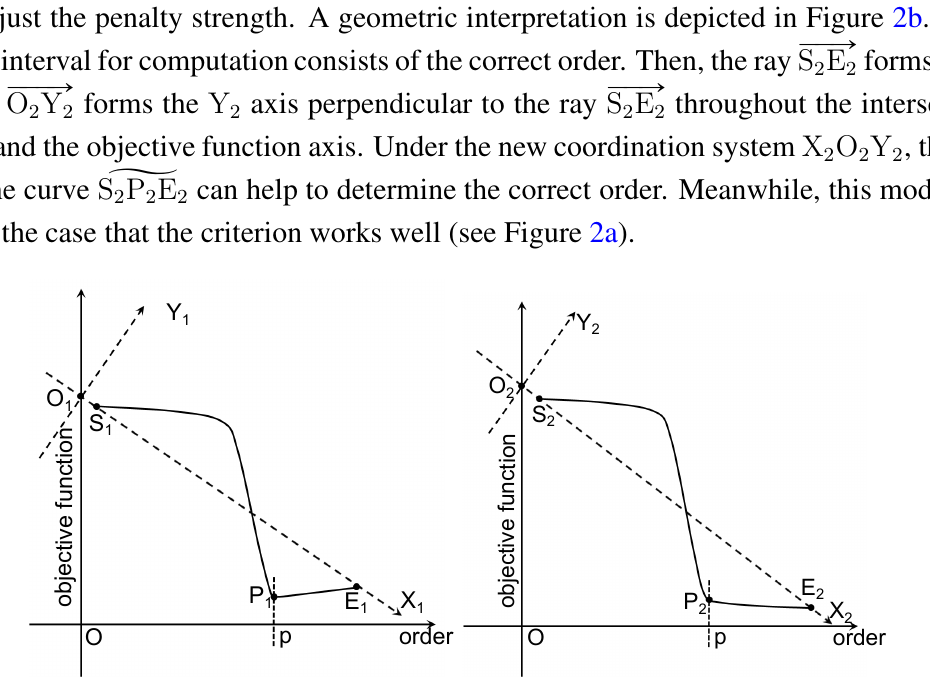
S P E S P E and draw 1 1 1 2 2 2 1 Č Č O Y , the point P becomes the minimum point of 2 2 2 2